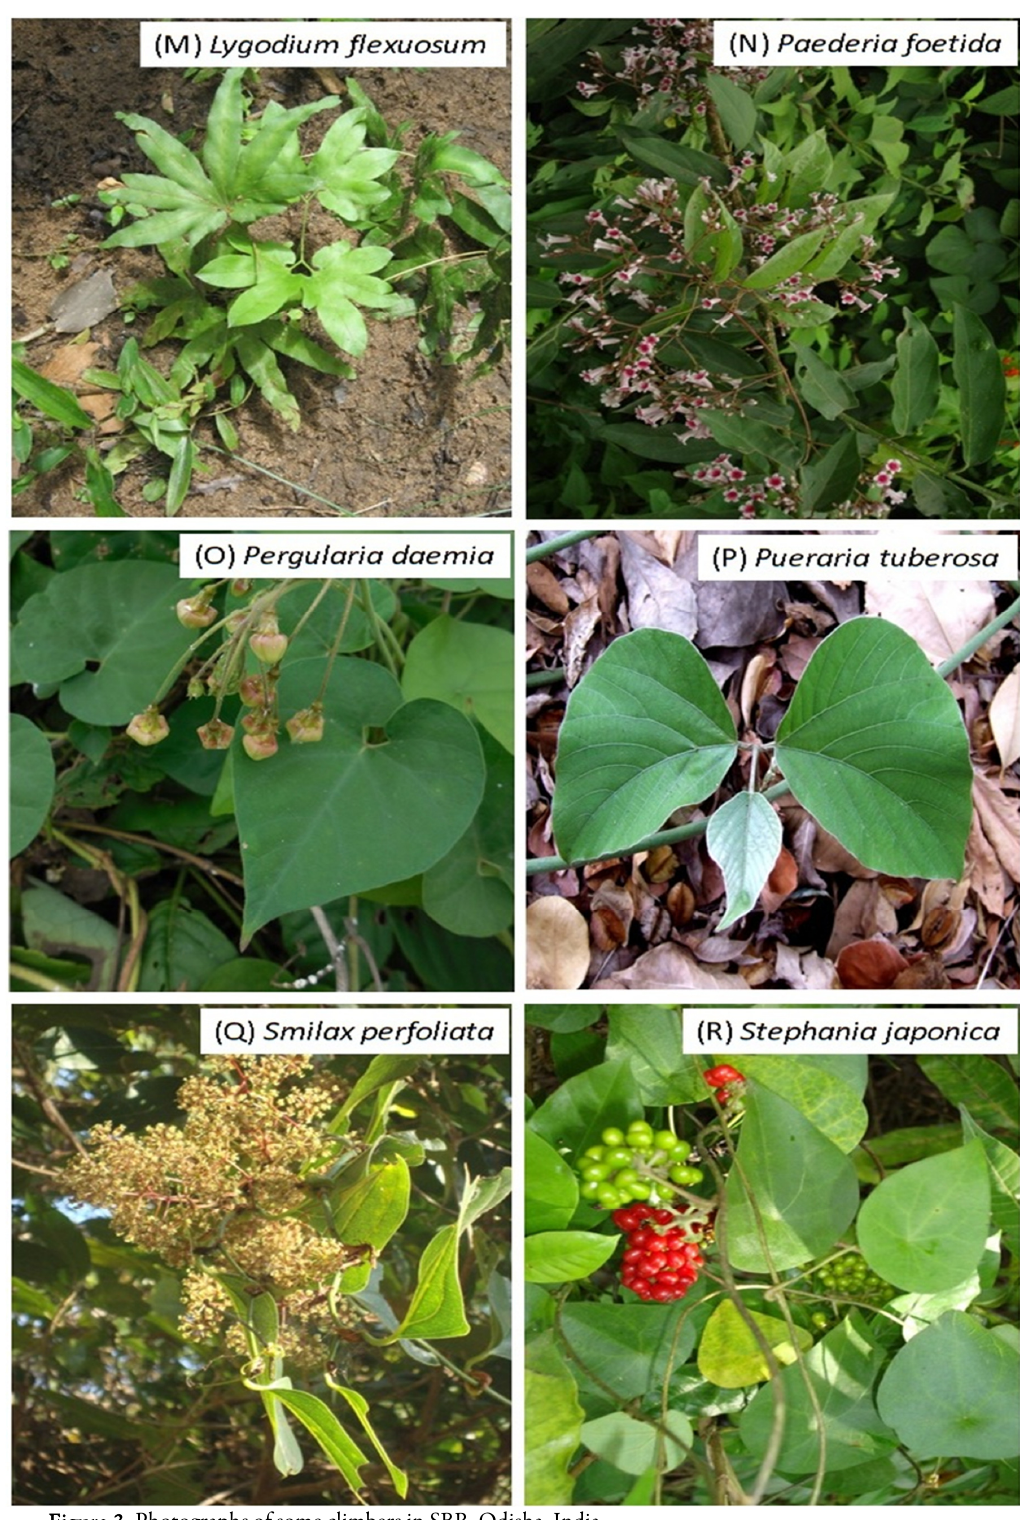
Figure 3. Photographs of some climbers in SBR, Odisha,